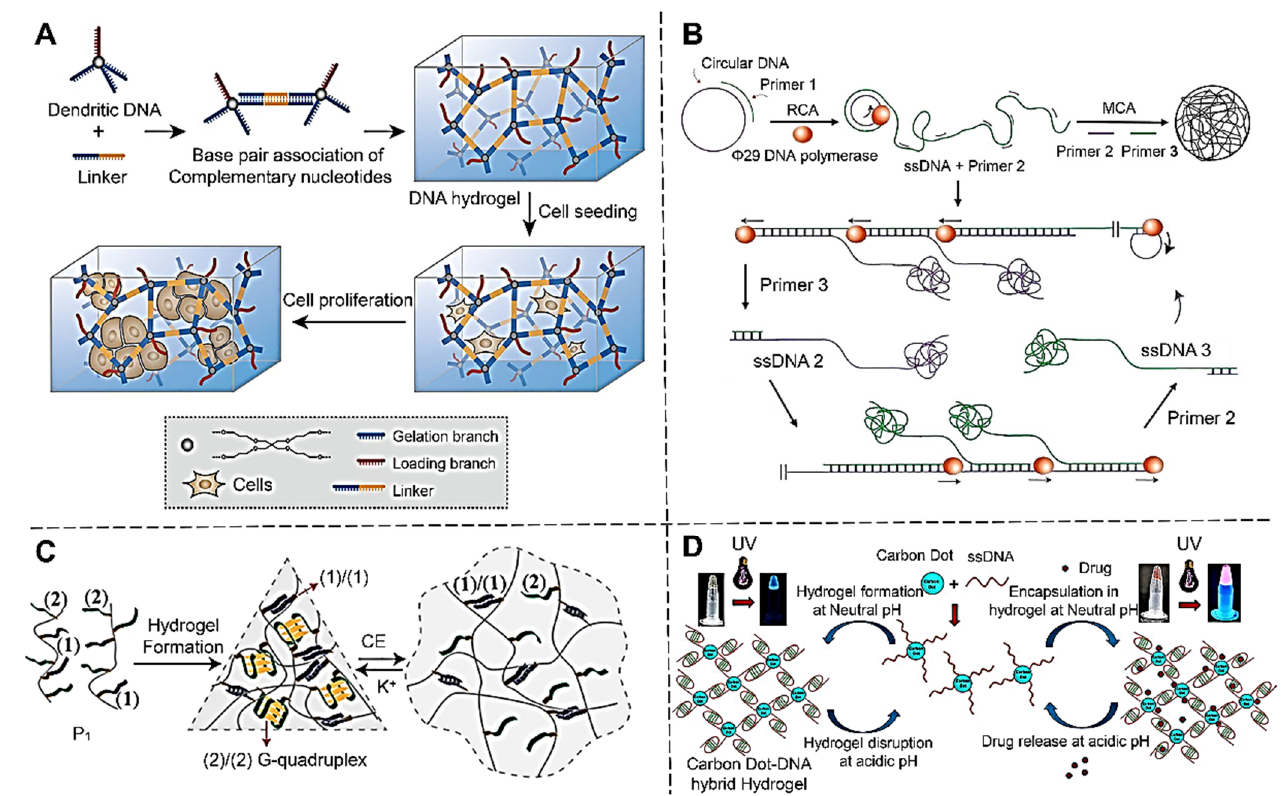
Figure 1. Typical strategies to construct DNA hydrogels: ( A ) Self-assembly of the dendritic DNA hydrogel. (Adapted with permission from [44]. Copyright (2021) American Chemical Society.) ( B ) Pure DNA hydrogels constructed by RCA. (Adapted with permission from [50]. Copyright (2012) Nature Research.) ( C ) DNA crosslink polyacrylamide chains to construct the hybrid hydrogel. (Adapted with permission from [55]. Copyright (2015) American Chemical Society.) ( D ) The construction of DNA-carbon dot hybrid hydrogel. (Adapted with permission from [30]. Copyright (2017) Elsevier.)